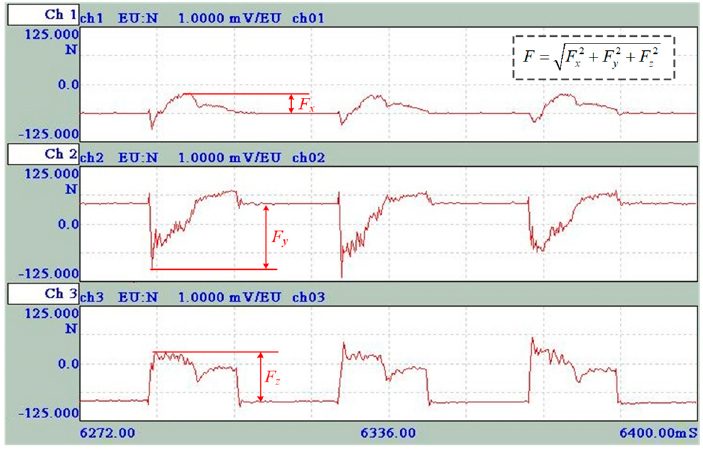
Figure 3. Typical cutting force signal spectrum in asymmetric milling (trial No. 9).